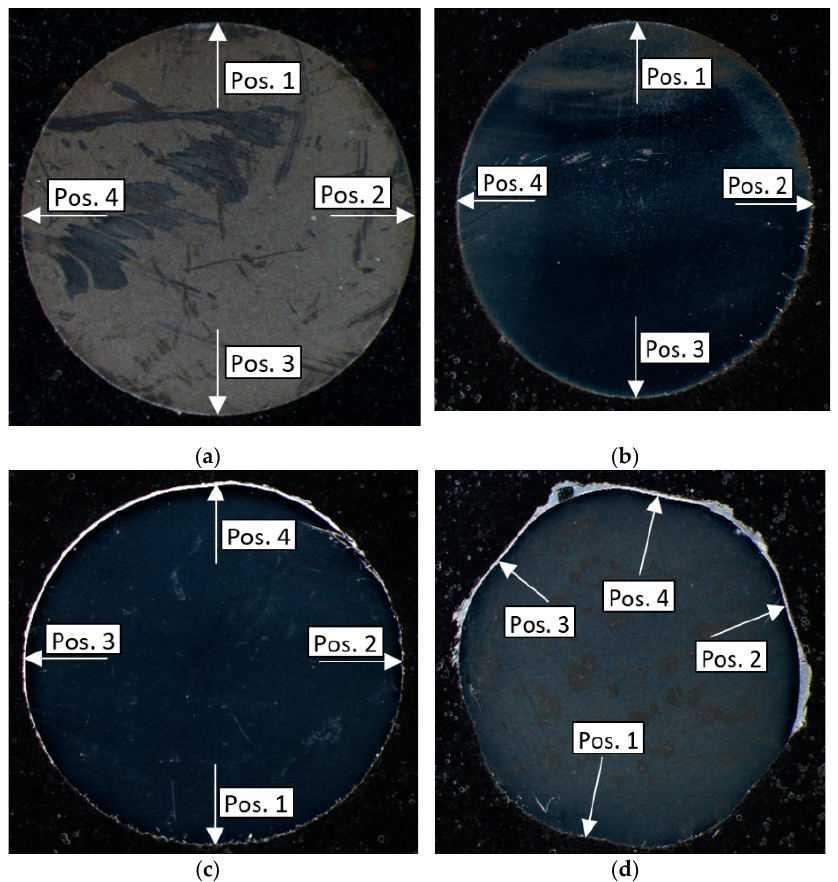
Figure 3. Macro-views of the cross-sectional area of wires, nominal diameter 5.4 mm: ( a ) conventional, ( b ) phosphated, ( c ) galvanized, ( d ) compacted.